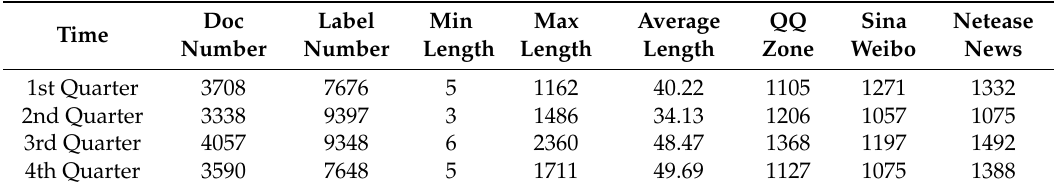
Table 2. Information in unified model.